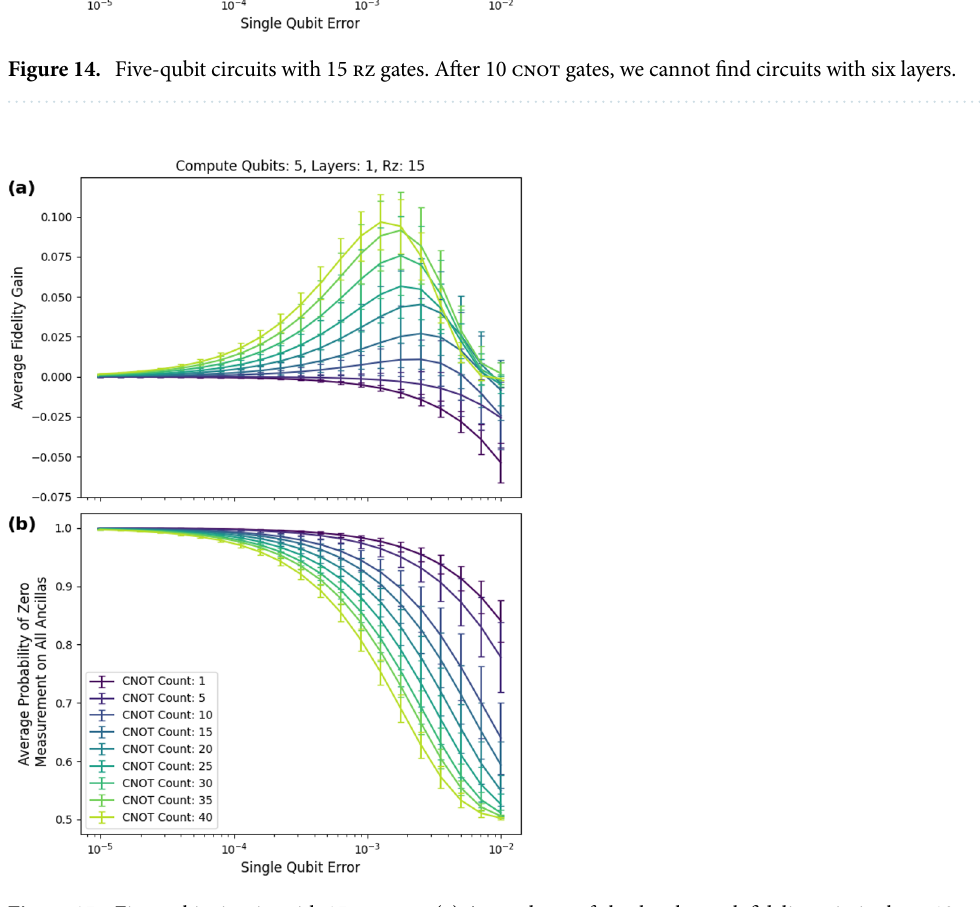
Figure 15. Five-qubit circuits with 15 rz gates. ( a ) At one layer of checks, the peak fidelity gain is about 10 percentage